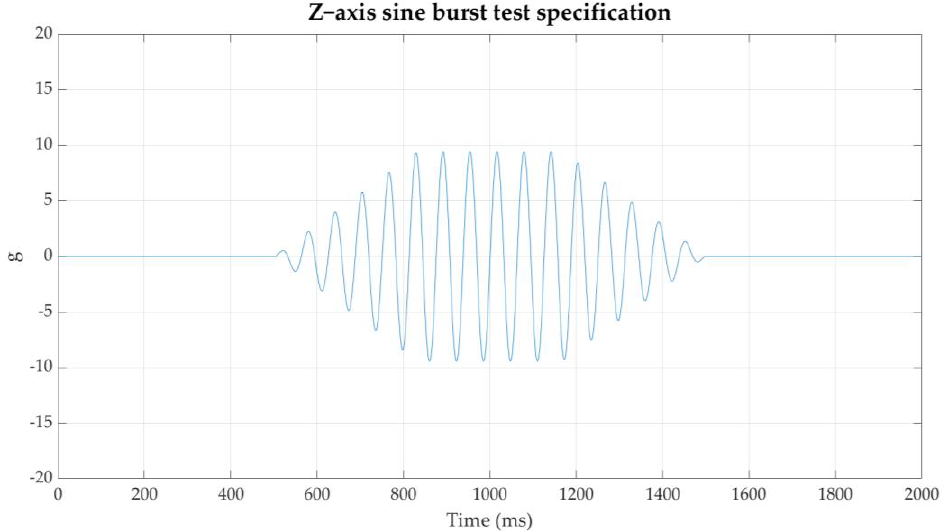
Figure 10. Z-axis sine burst test specification of g-force acceleration (in units of g = 9.8 m s − 2 ) with respect to time.